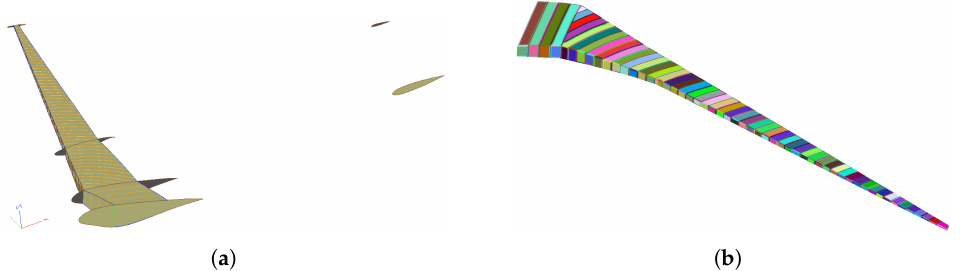
Figure 2. ESP parameterization of the uCRM. ( a ) ESP geometry used for LF analyses showing designable airfoil shapes at the wing Yehudi and tip. ( b ) Faces of IML geometry components with varying thickness (color variations only used to denote different